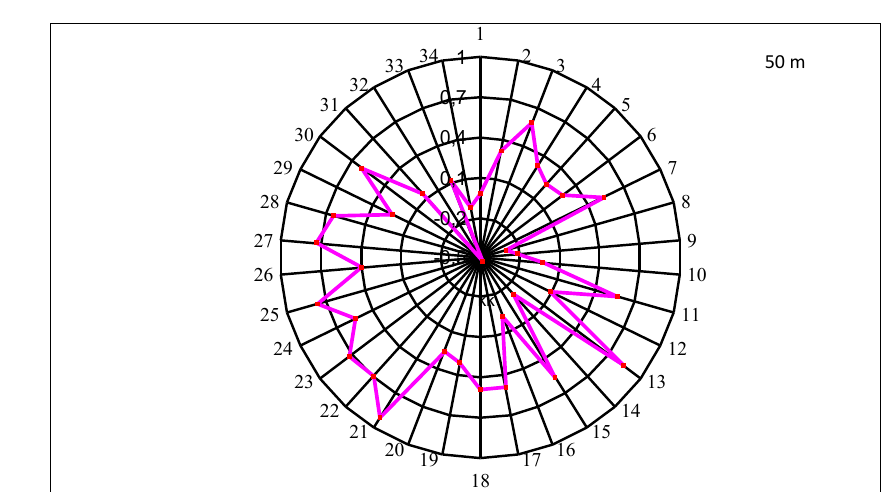
Fig.2. Correlation of elite sportsmen’s morphological functional indicators with results of 50 meters’ breaststroke: 1 – body length (cm), 2 – body weight (kg), 3 – arm’s length (cm), 4 – arm span (cm), 5 – hand’s length (cm), 6 – length of forearm (cm), 7 – length of shoulder (cm), 8 – length of leg (cm), 9 – length of hip (cm), 10 – length of shin (cm), 11 – length of foot (cm), 12 – torso length (cm), 13 – width of foot (cm), 14 – width of shoulders (cm), 15 – width of pelvis (cm), 16 – width of hand (cm), 17 – circumference of chest in rest (cm), 18 – circumference of chest in inhale (cm ), 19 – circumference of chest at exhale (cm), 20 – circumference of tensed arm (cm), 21 – circumference of relaxed arm (cm), 22 – circumference of forearm (cm), 23 – circumference of wrist (cm), 24 – circumference of waist (cm), 25 – circumference of buttocks (cm), 26 – circumference of hip (cm), 27 – circumference of knee (cm), 28 – circumference of shin (cm), 29 – circumference of ankle (cm), 30 – heart beats rate (HBR), in lying position during 10 seconds, (beats), 31 – ЧСС в покое за 10 с (уд), 32 – HBR after load during 10 seconds (beats), 33 – vital capacity of lungs (VCL) (l), 34 – forward bents (cm).